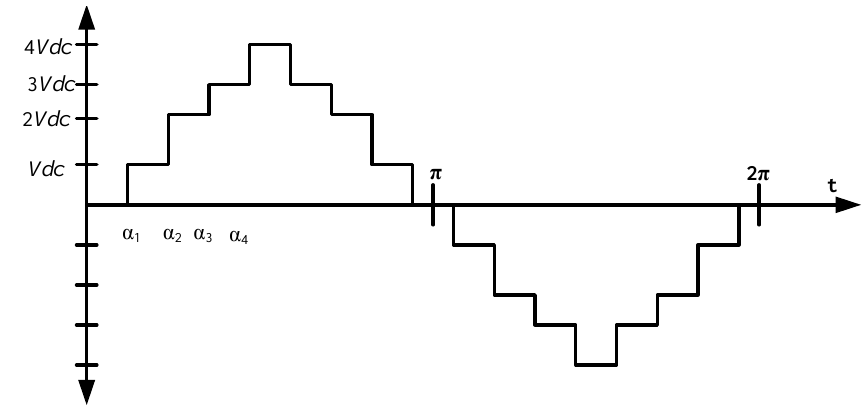
Figure 8. Output waveform pattern with non-equal DC source of single phase 9-level CHB-MLI. Four switching angles α 1 , α 2 , α 3 and α 4 are calculated by solving non-linear equating by GA to minimize the THD and resulting output waveform pattern with non-equal DC source of single phase 9-level CHB-MLI is shown in Figure 8